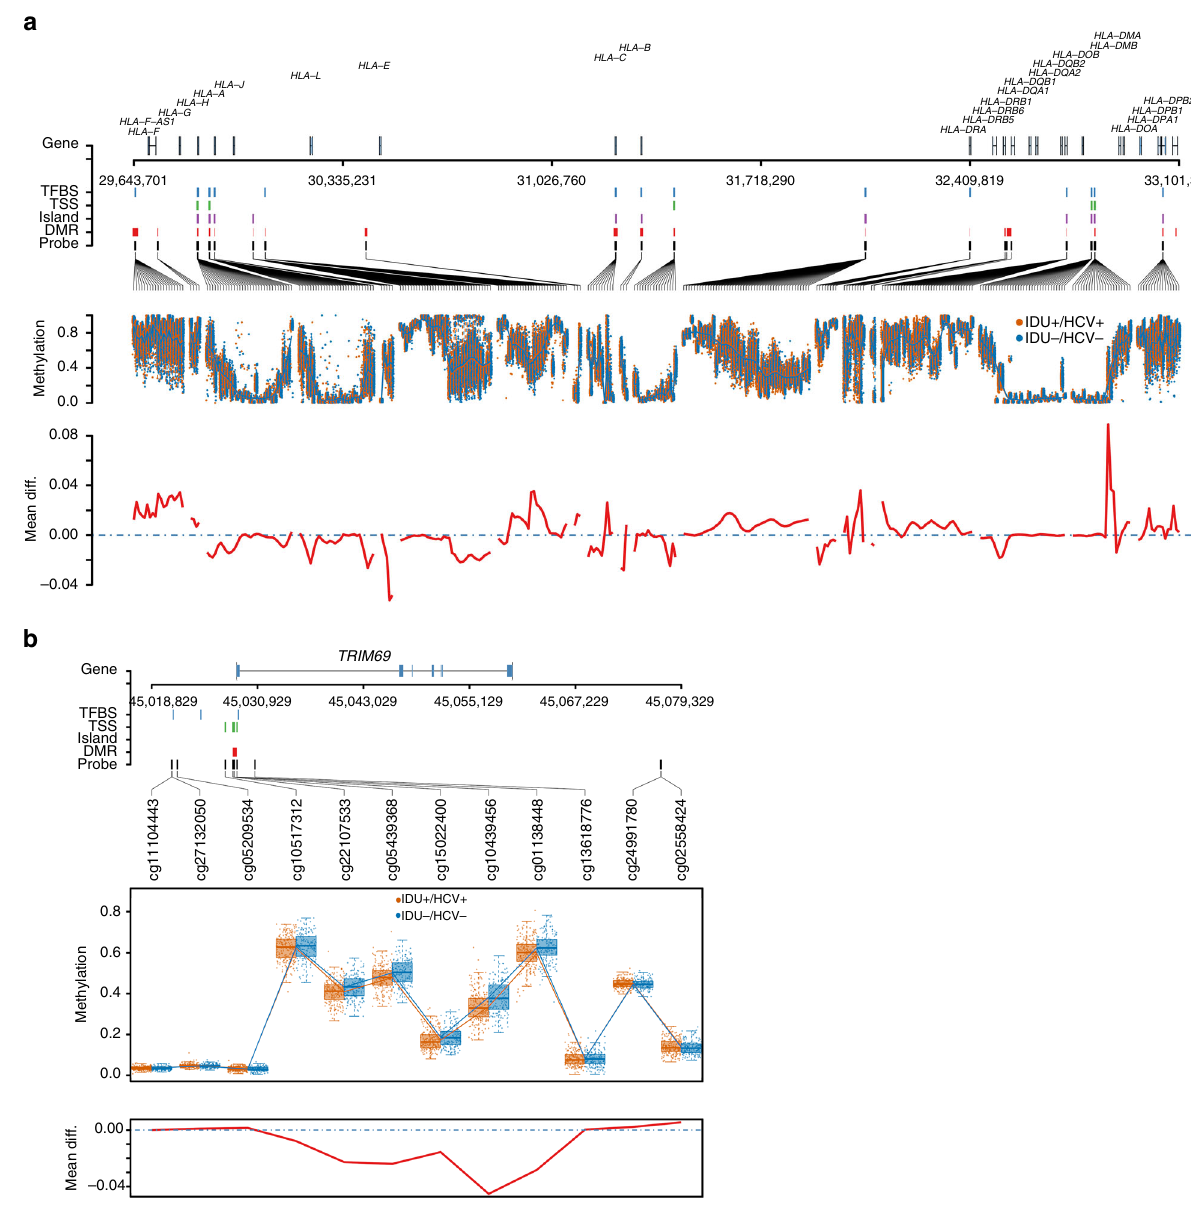
distant clusters, IDU+/HCV+ and IDU − /HCV − ( p = 4.65E − 27) (Fig. 3a). These two clusters were not associated with other clinical and HIV-related phenotypes, e.g., medication adherence, age, HIV viral load, CD4 counts, and CD8 counts ( p > 0.1). To con fi rm this result, we performed a t-distributed stochastic neighbor embedding (t-SNE) clustering analysis, a machine- learning approach for high-dimensional data reduction 29 . Con- sistent with the results of hierarchical clustering analysis, the result of t-SNE for 748 residual methylation probes showed dis- tant clusters for IDU+/HCV+ and IDU − /HCV − groups (Fig. 3b).